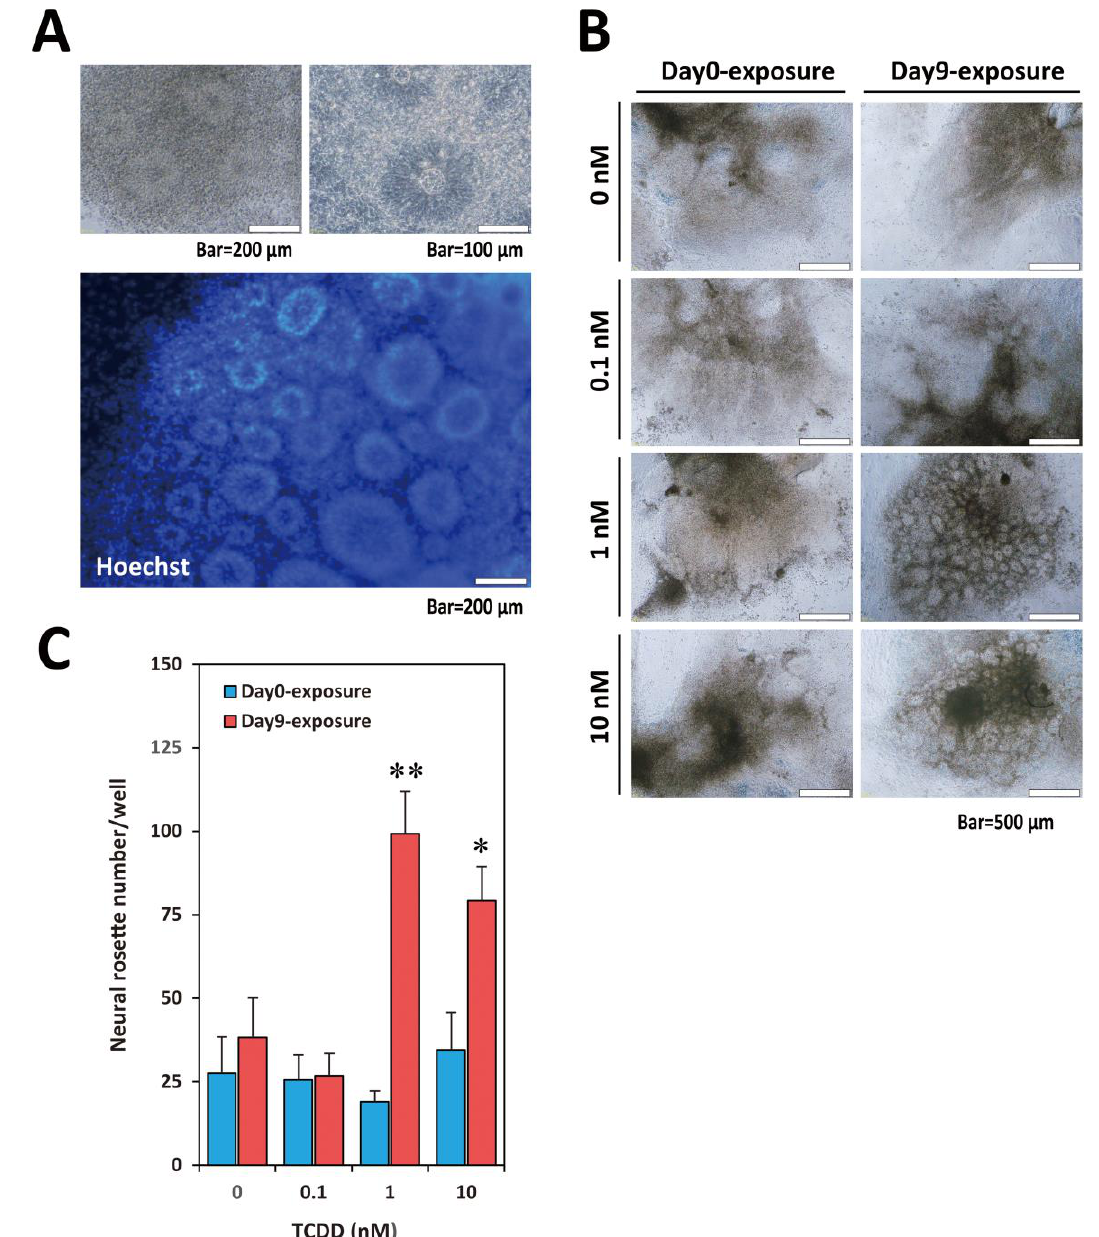
Figure 2. Effects of TCDD exposure on the neural rosette appearance. ( A ) Representative neural rosette. Lower panel shows results for Hoechst staining. ( B ) Bright-field image of differentiating neural cells on Day25. Compared with Day0-exposure groups, numbers of neural rosettes were remarkably increased in Day9-exposure groups in the dishes with 1 nM and 10 nM TCDD. ( C ) Neural rosette number. The total number of visible and countable rosettes was counted in one well ( N = 4). One-way ANOVA was carried out followed by Dunnett’s test as the post hoc (*, p < 0.05; **, p < 0.01).